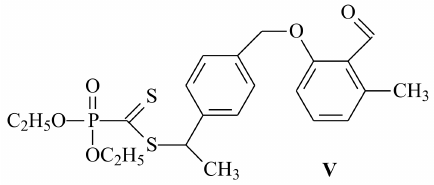
Figure 4. The structure of (1-(4-((2-formyl-3-methyl phenoxy)methyl)phenyl)ethyl (diethoxyphos- phoryl) methane